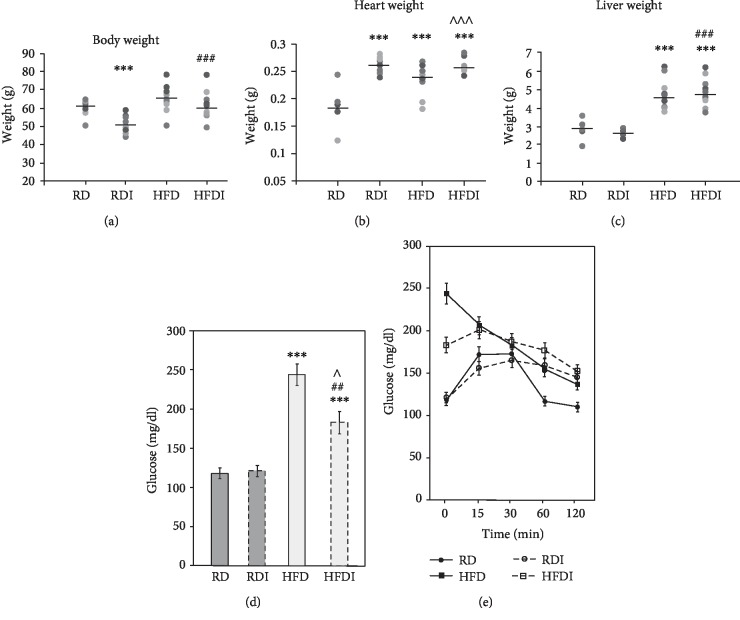

T. cruzi infection altered body weights and glucose levels in chronic mice fed on different diets. (a) T. cruzi-infected HFD mice displayed greater body weight compared to infected RD-fed mice at 150 DPI. (b) T. cruzi infection increased the weights of the hearts compared to uninfected mice irrespective of the diets fed at 150 DPI. (c) The weights of the livers of HFD-fed mice (both uninfected and infected) were significantly increased compared to RD-fed (both uninfected and infected) mice. T. cruzi infection showed no significant effect on the weights of the livers. (d) Serum glucose measurements demonstrated that chronic T. cruzi infection has no significant effect on the levels of fasting glucose in RD-fed mice. However, the levels of fasting glucose significantly increased in infected HFD mice compared to infected RD-fed mice. (e) Infected HFD mice showed a better clearance of glucose during OGTT analysis compared to infected RD mice even though the basal levels of glucose were significantly greater in infected HFD mice compared to infected RD mice. The error bars represent standard error of the mean. ∗p ≤ 0.05, ∗∗p ≤ 0.01, or ∗∗∗p ≤ 0.001 compared to uninfected RD mice. #p ≤ 0.05, ##p ≤ 0.01, or ###p ≤ 0.001 compared to infected RD mice. ^p ≤ 0.05, ^^p ≤ 0.01, or ^^^p ≤ 0.001 compared to uninfected HFD mice. A bar represents the mean value in (a–c).